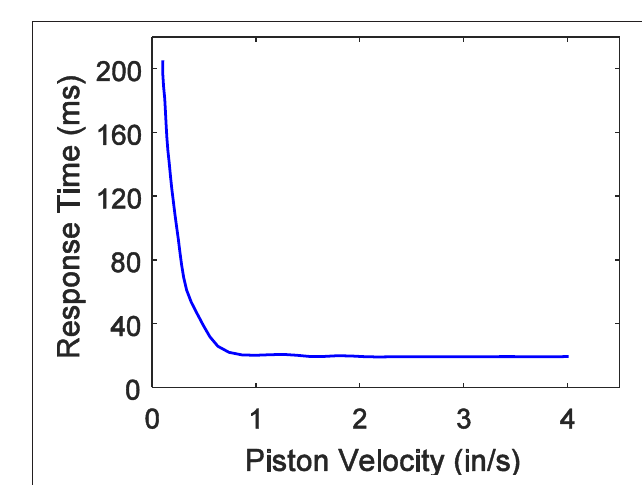
FIGURE 9 | Dipole model-based hysteresis characteristics of MR fluids under reciprocating displacement excitations: (A) large amplitude and (B) small amplitude.